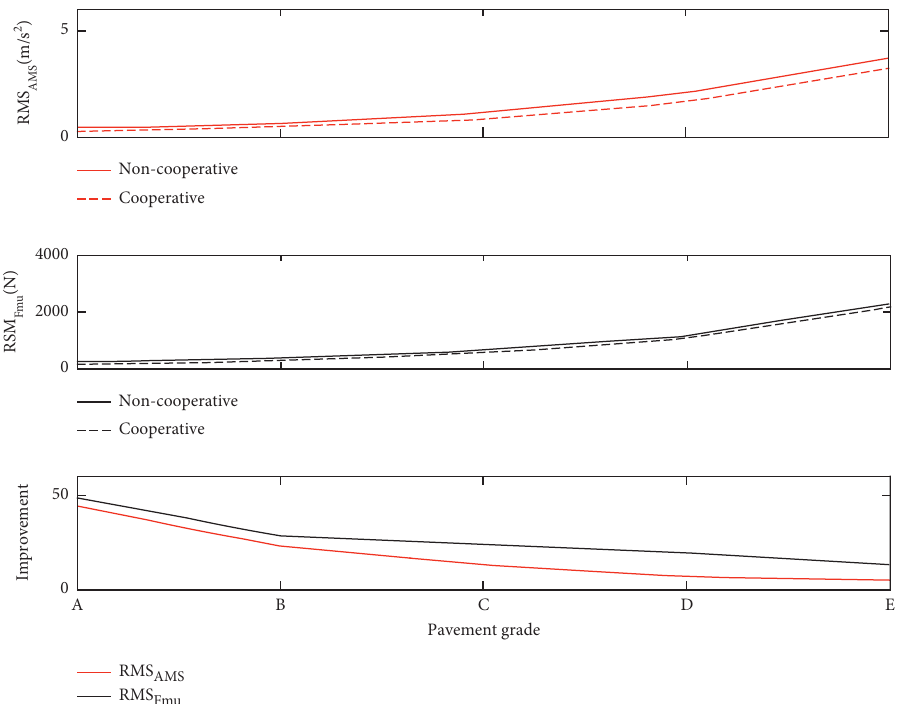
Figure 13: Influence of cooperative control and noncooperative control.